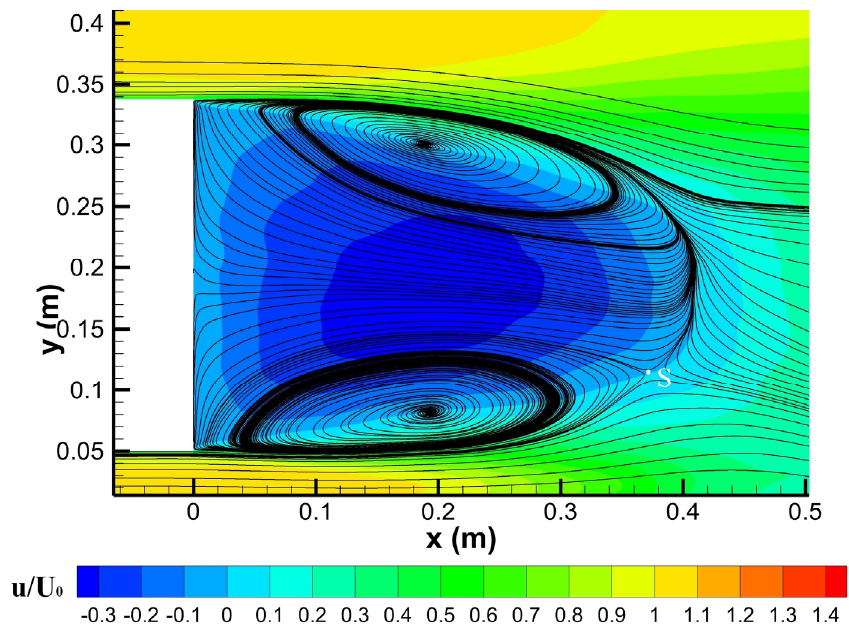
Figure 9. Time-averaged streamlines in the behind of the model, on symmetry plane of baseline flow.